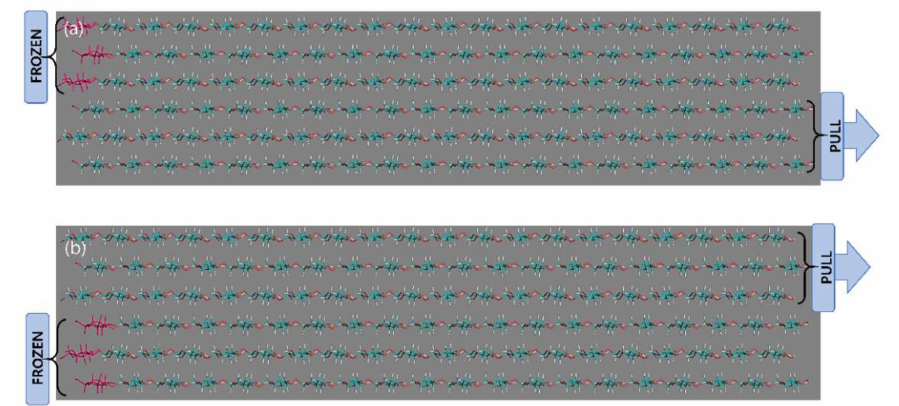
Figure 2. Case B for ( a ) freeze upper (front) pull bottom (back) denoted by FUPB, and ( b ) freeze bottom (front) pull upper (end) denoted by FBPU throughout the